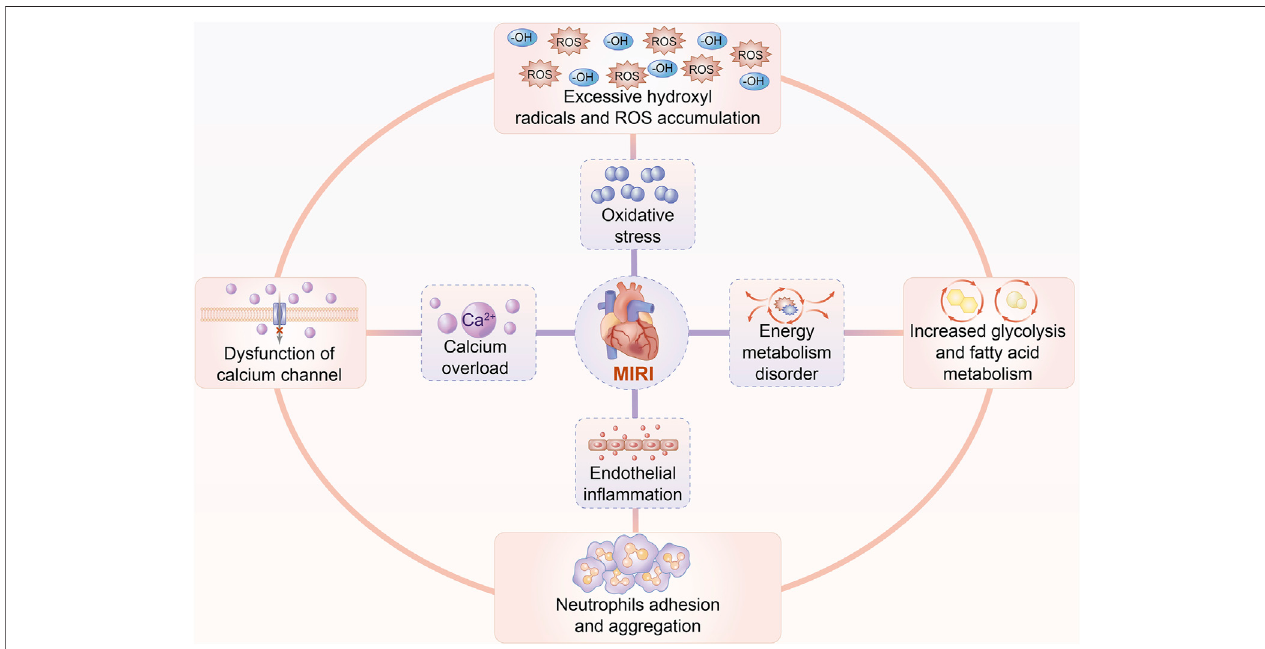
FIGURE2| PathophysiologyofcardiomyocyteIRI.MultiplefactorsareinvolvedinthepathogenesisandprogressionofMIRI,includingoxidativestress,endothelial cell in fl ammation, calcium overload, and energy metabolic disturbance. Excessive ROS and hydroxyl radicals are produced to trigger peroxidative stress. Chemotaxis, adhesion, and aggregation of neutrophils initiate in fl ammatory cytokine release, in turn inducing endothelial cell injury. Calcium overload suppresses excitability and contractility of cardiomyocytes due to the dysfunction of the L-type calcium channel as well as the ryanodine receptor. Increased glycolysis and fatty acid metabolism, as well as mitochondrial dysfunction, ultimately deteriorate the disorder of energy metabolism.